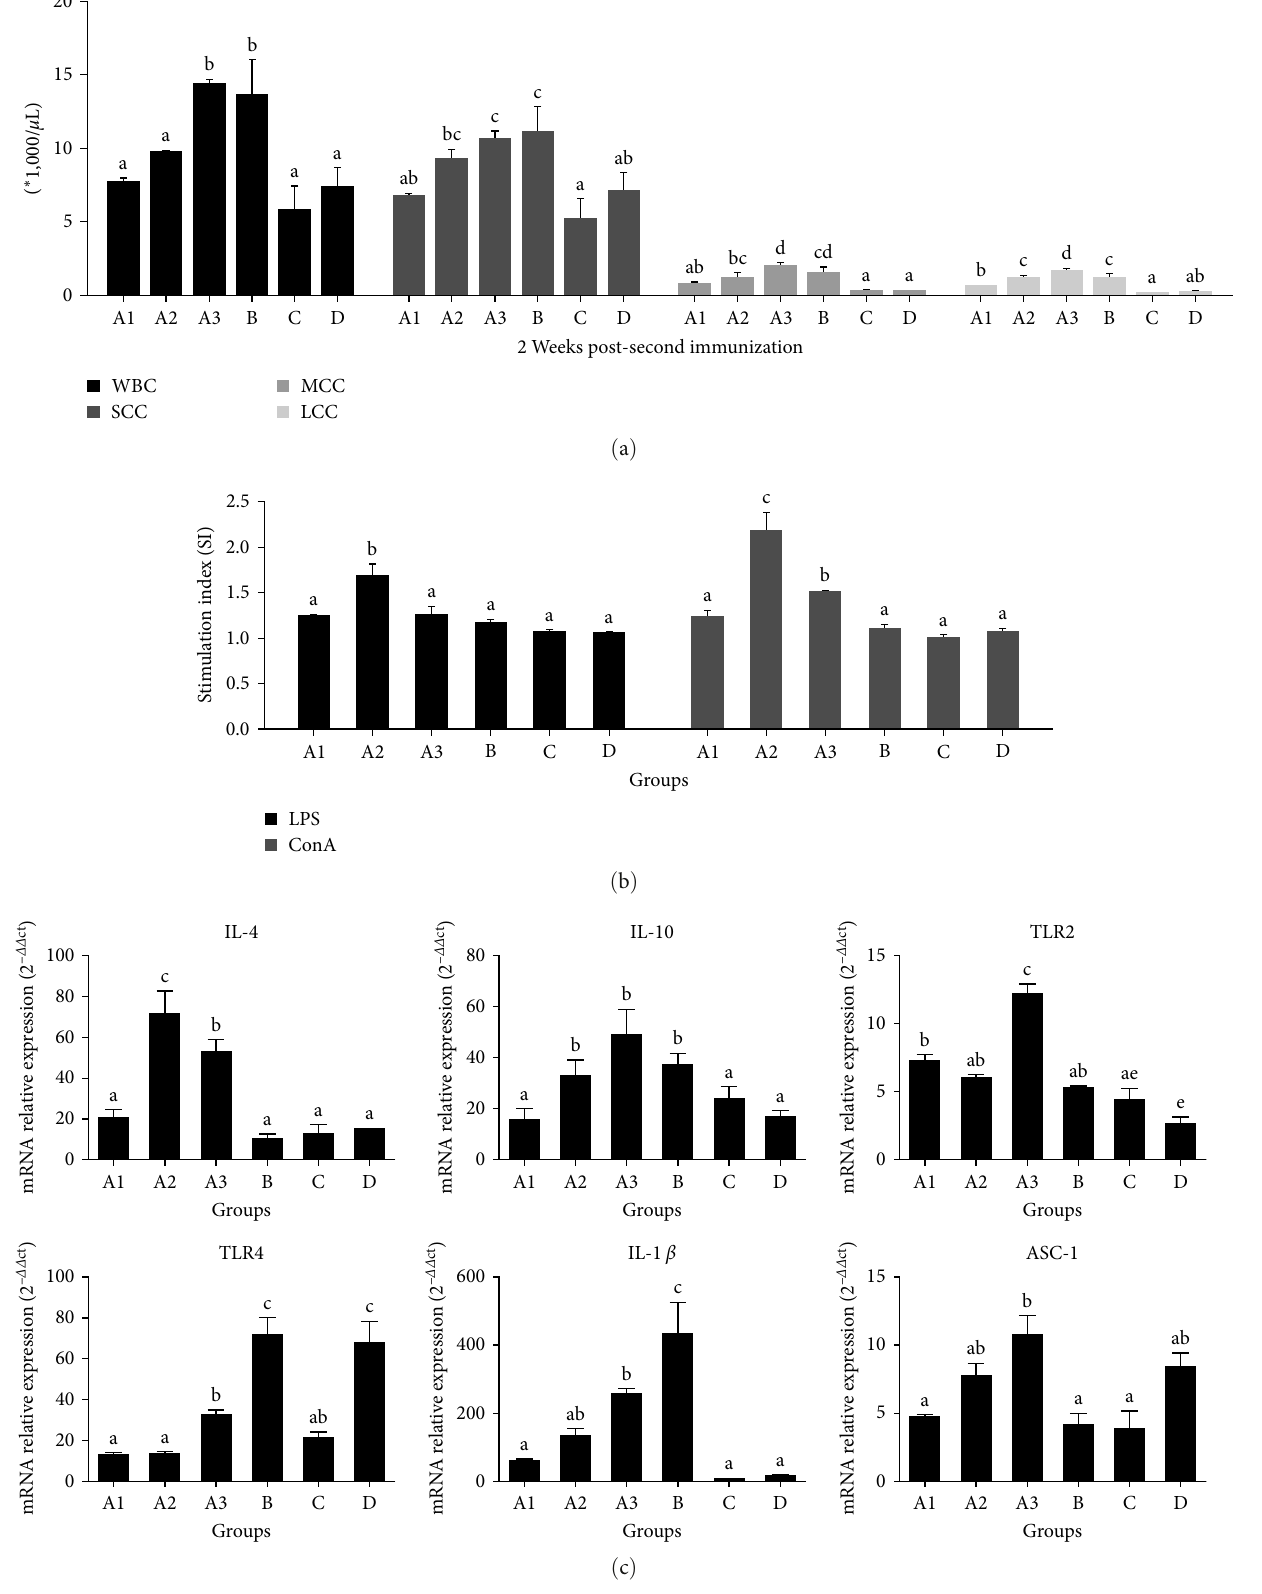
F IGURE 2: Results of blood analysis, splenocyte proliferation analysis, and the expression level of cytokines and the relevant factors. Different letters above the bar indicate the presence of signi fi cant differences among the groups ( P < 0 : 05). Groups A1, A2, and A3 stand for (ECMS200 μ g-oil, ECMS 400 μ g-oil, and ECMS800 μ g-oil) group. Group B stands for oil group, group C stands for EMCS800 μ g group, group D stands for phosphate buffer saline